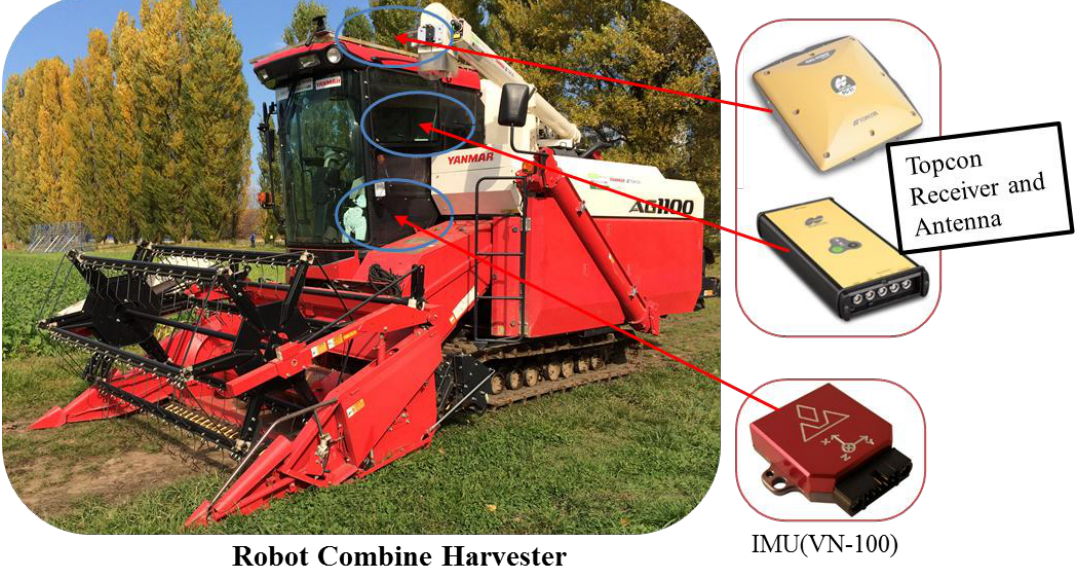
Figure 2. View of the robot combine harvester equipped with RTK-GPS and IMU sensors.